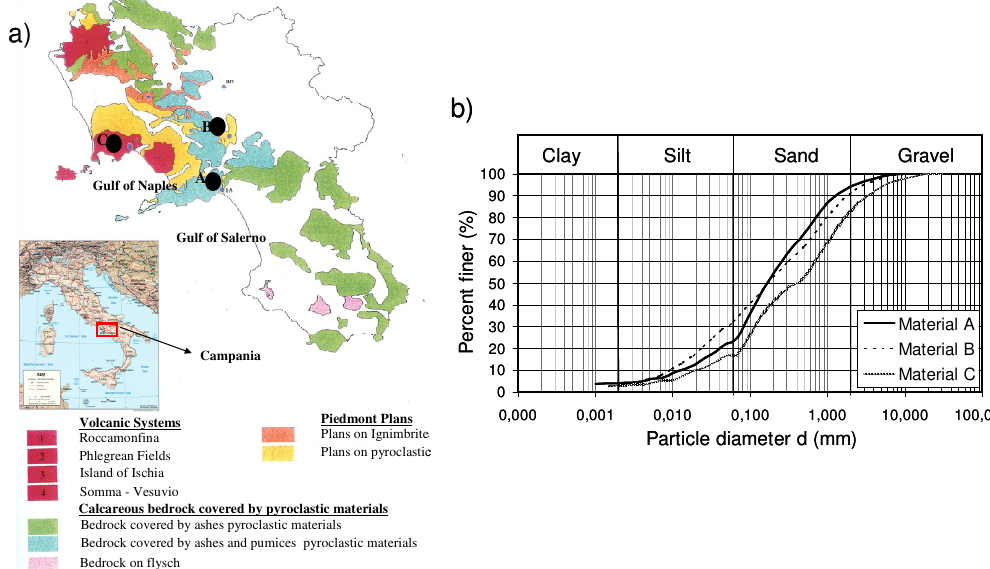
Fig. 3. (a) Location of the studied debris flows and distribution of the main deposits (Modified from di Gennaro et al., 1998); (b) Grain size distribution of the tested debris flow